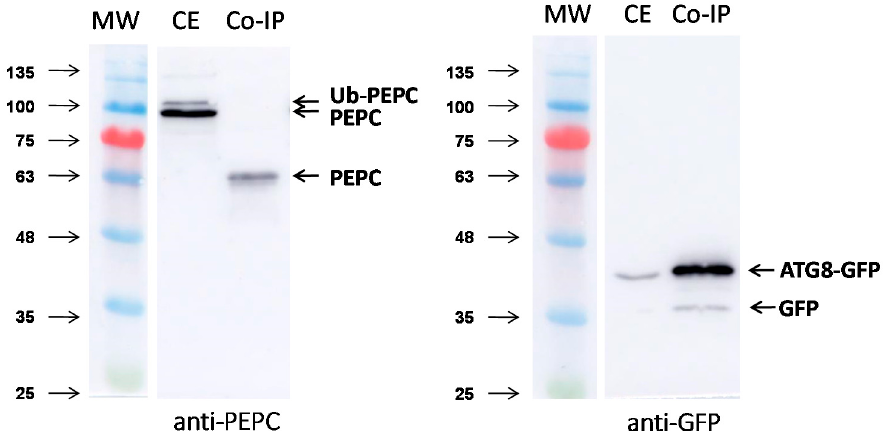
Figure 9. Co-immunoprecipitation of PEPC with GFP-ATG8CL in N. benthamiana . A transformed Agrobacterium tumefaciens strain GV3101 line carrying potato ATG8CL fused to green fluorescent protein (GFP) has infiltrated N. benthamiana. At 60 h after agroinfiltration, proteins were extracted from infiltrated leaves using a 2 mL GTEN buffer per g of tissue. Crude extracts were incubated with GFP-Trap ® _A (Chromotek) for 2 h at 4 ◦ C. Then, extracts were centrifuged at 1000 g for 2 min at 4 ◦ C, washed five times, and co-precipitated proteins were eluted by heating at 95 ◦ C for 5 min with a dissociation buffer. Afterwards, 15 µL of the crude extracts (CE) and co-precipitated proteins (Co-IP) were immunoblotted with the anti-PEPC (left) and anti-GFP (right) antibodies.